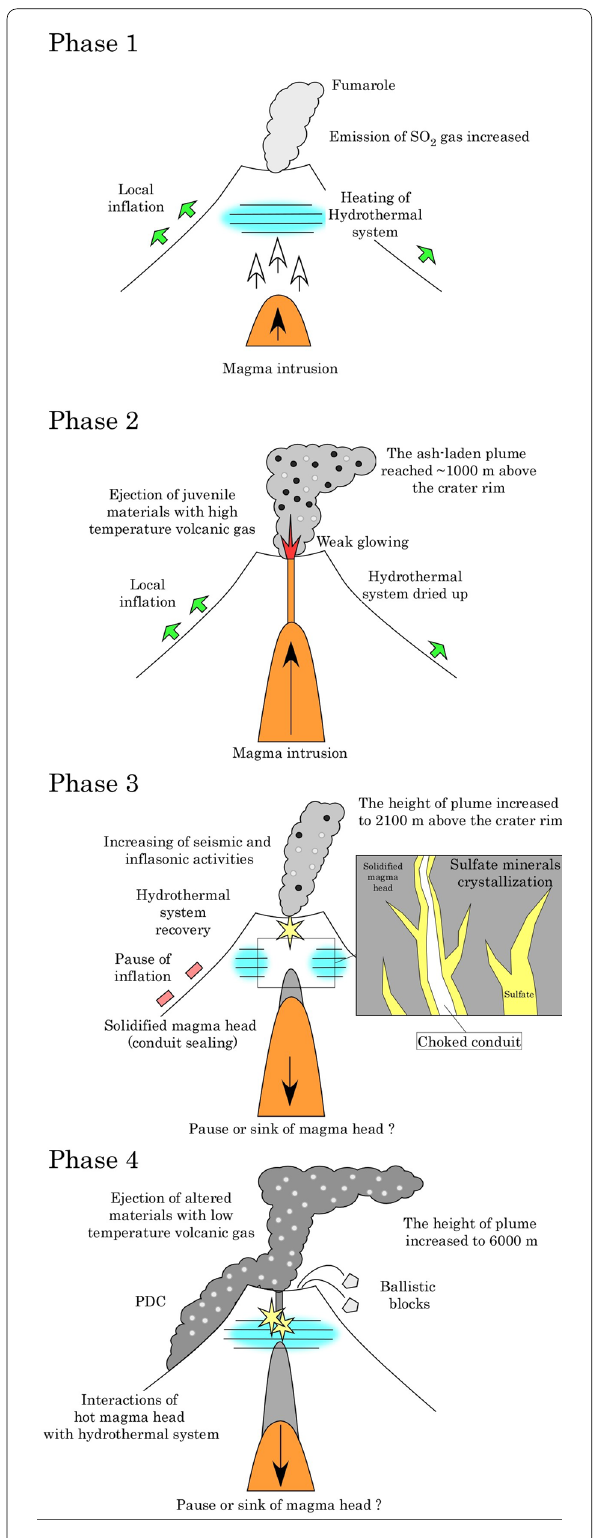
Fig. 9 Schematic illustrations showing the sequence of the 2018–2019 eruption at Kuchinoerabujima Volcano. Shallow ascending magma dried up a hydrothermal system beneath the eruption vent (Phase 1). Magmatic eruption occurred during Phase 2. The eruption products contain juvenile (dark circle) and altered materials (white). Continuous ash emission and weak glowing from the crater suggested a sufficiently high temperature for the crater. Edifice inflation paused in Phase 3. Hydrothermal fluid recovered in the shallow edifice. Precipitation of sulfate minerals choked the conduit. Explosive activities with PDCs occurred during Phase 4 due to interaction between magma and hydrothermal